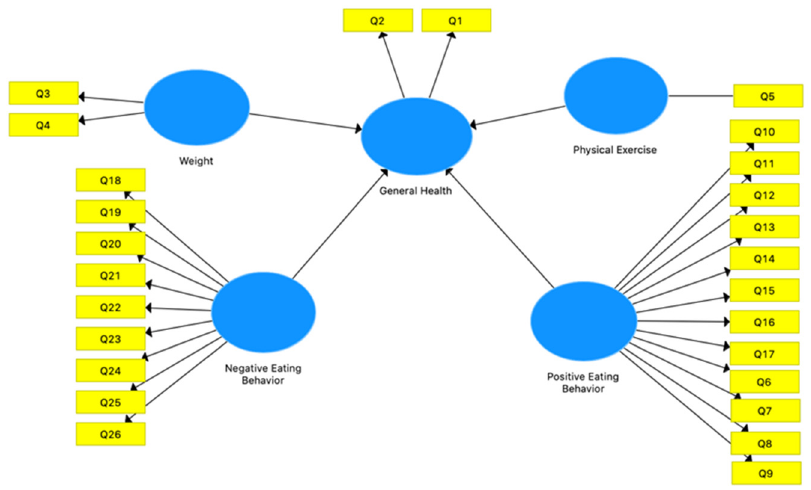
Figure 1. Theoretical Path Model.